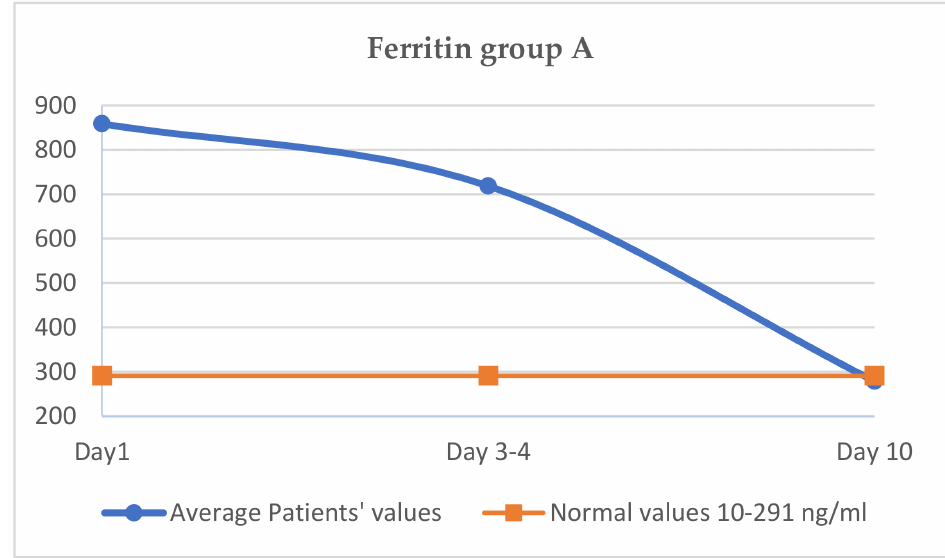
Figure 3. Variation of ferritin group A. Group B, which included cytokine storm patients treated with Remdesivir and Anakinra: 3.6. Evaluation of CRP Variation (Normal Values 0–5 mg/L) The mean value of CRP in day 1 of the treatment was 130.3 mg/L, on day 3–4 it was 108.1 mg/L and on day 10 it reached 40.9 mg/L (Figure